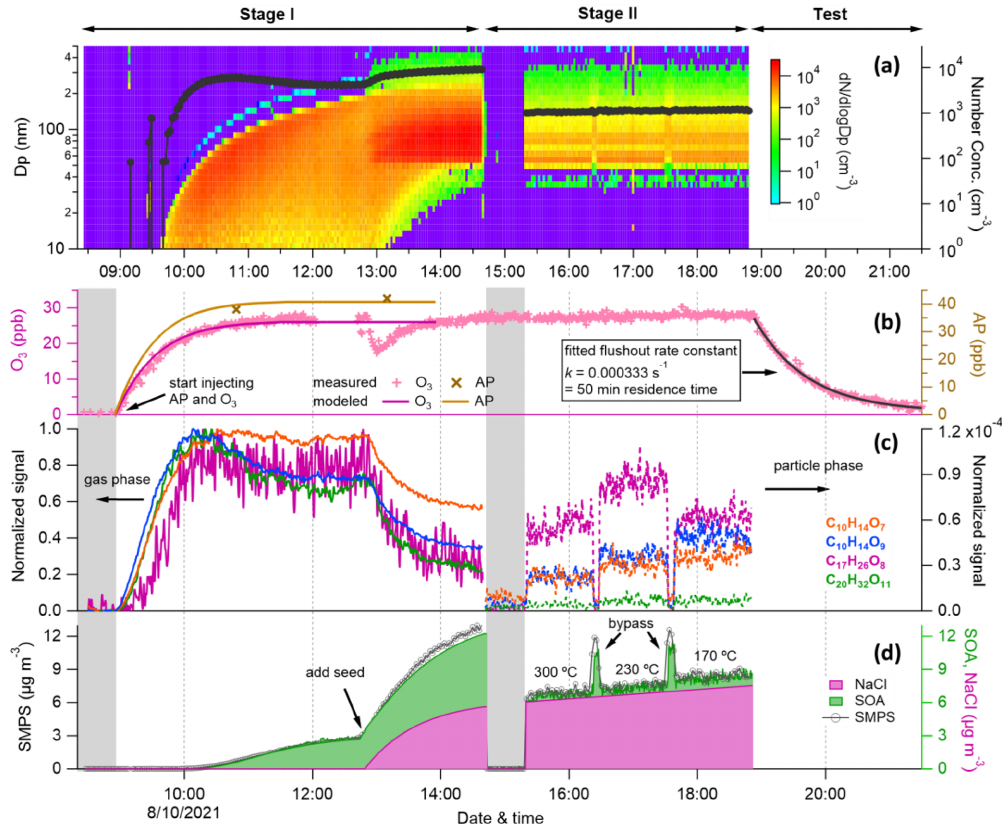
Figure 2. Overview of experiment no. 1 (input flow with 53ppb α -pinene and 33ppb O 3 ). (a) Particle number concentration and size distribution sampled by SMPS as a function of time. Time series of (b) measured and modeled ozone and α -pinene concentration (1min averaged) in the chamber; (c) gas-phase (solid lines, normalized to reagent ions at first and then to their maximums) and particle-phase (dashed lines, normalized to reagent ions) HOM species (10s averaged); (d) total aerosol, organics, and sodium chloride mass concentrations from SMPS (2.2min averaged, black circles) and AMS measurements (20s averaged). The first and second shaded areas are gas-phase and particle-phase background measurements, respectively. Note that the time series of NaCl was estimated using the method explained in the Supplement owing to the lack of measurements, and no measurements given above were corrected for chamber wall